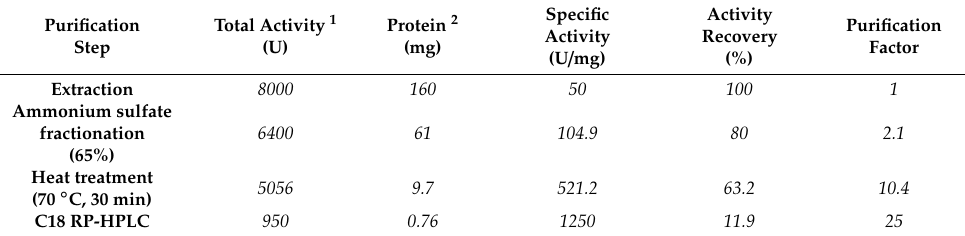
Table 1. Characterization of Wa PLA 2 -II at each purification